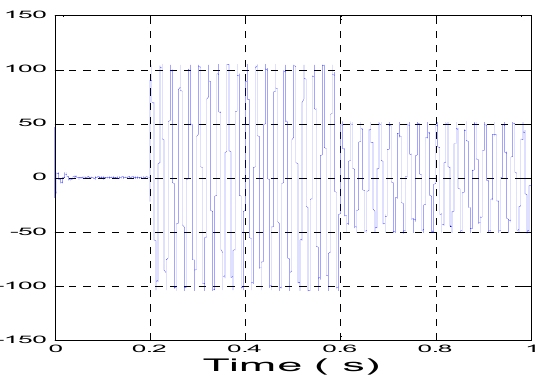
Figure 20. The stator current and voltage.